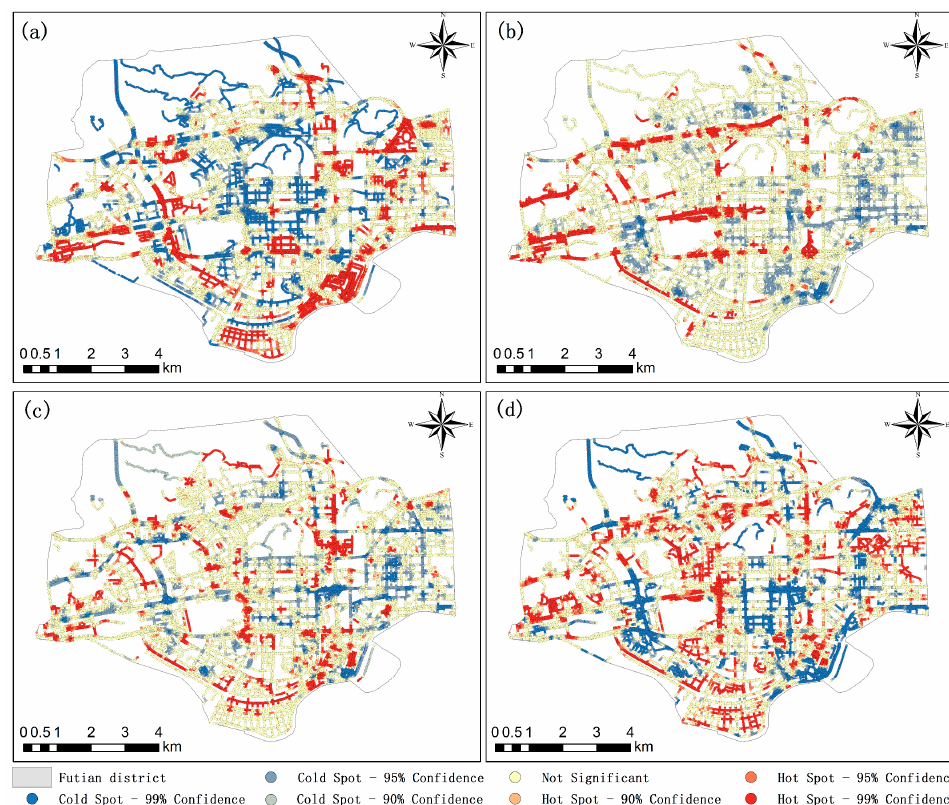
Figure 5. Hot spot analysis results of the correlation factors: ( a ) LST hot spot analysis results, ( b ) grass ratio results, ( c ) shrub ratio results and ( d ) tree ratio results.